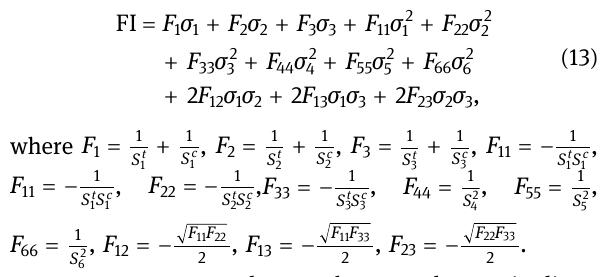
Figure 5: FEA model of interference fi t joint.